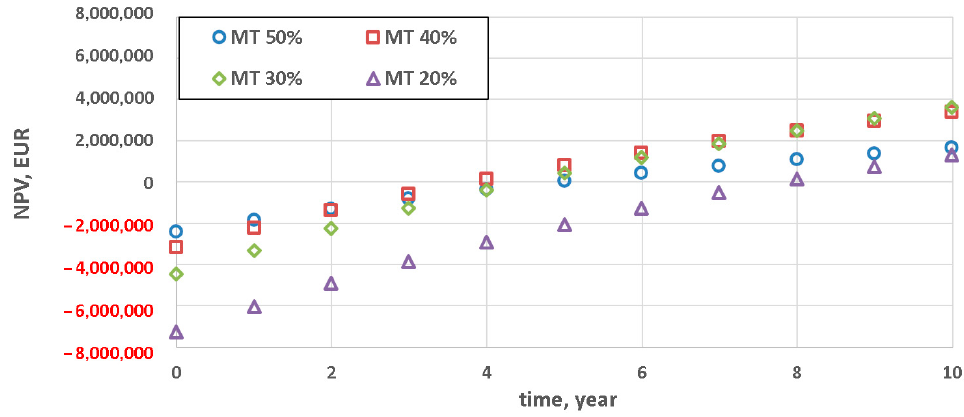
Figure 5. Results of NPV analysis for different variants of achievable power unit technical minimum (MT) at coefficient Y = 1 (identical power of plasma torches assumed for all technical minimum levels).